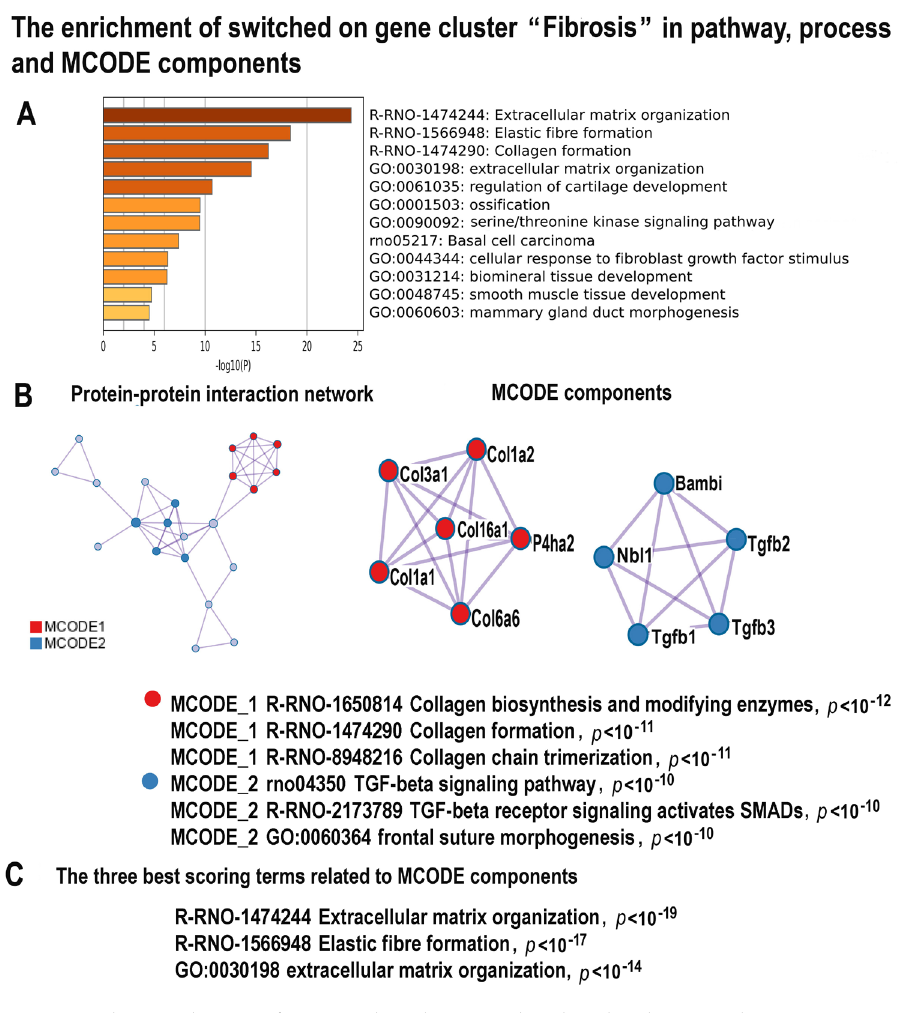
Figure 6. The enrichment of NLI − induced genes related to the cluster “Fibrosis” in gene pathway and process and in molecular complexes. ( A )—Bar graph of enriched terms related to gene pathways and processes across the gene cluster related to fibrosis. The statistical significance of enrichment is shown in X -axis ( − log10( p )). ( B )—Protein–protein interaction network and MCODE components (or densely connected network components) were identified in the gene list. The network and MCODE components were constructed on the base of physical interactions taken from the String server (physical score > 0.4). The coding by color square reflects the MCODE components. The coding by color circles indicates the results of MCODE component pathway and process enrichment analysis. ( C )—The three best-scoring terms related to MCODE